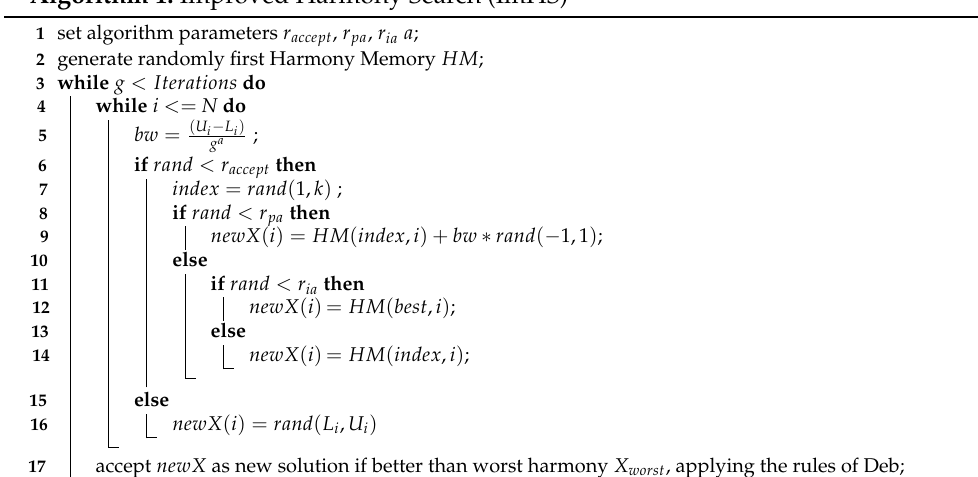
Algorithm 1: Improved Harmony Search